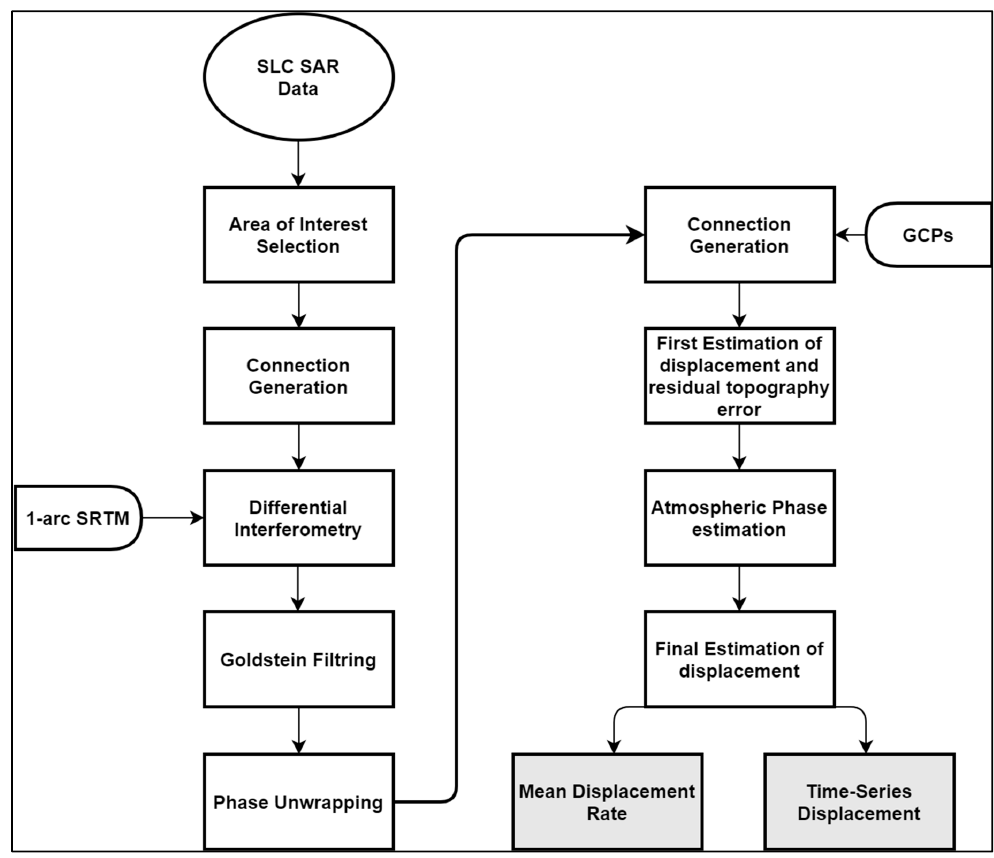
Figure 3. Flowchart of the small baseline subset (SBAS) processing used in this study [34] .